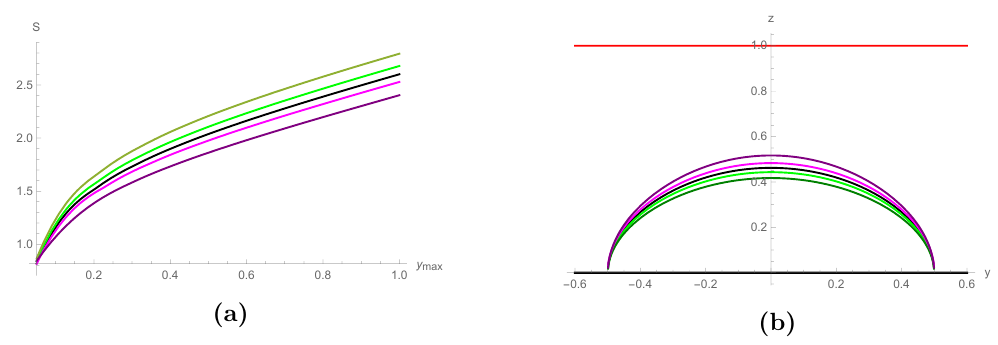
Figure 1. d = 3 planar black hole. a)Entanglement entropy as a function of the half-width of the boundary interval. b) Some representative minimal surfaces. In both plots we have used g = (cid:22) = (cid:12) = G = 1, and the values of (cid:13) are: (cid:13) = 0 (black), (cid:13) = (cid:0) 0 : 05 (light green), (cid:13) = (cid:0) 0 : 125 (dark green), (cid:13) = 0 : 05 (light purple) and (cid:13) = 0 : 125 (dark